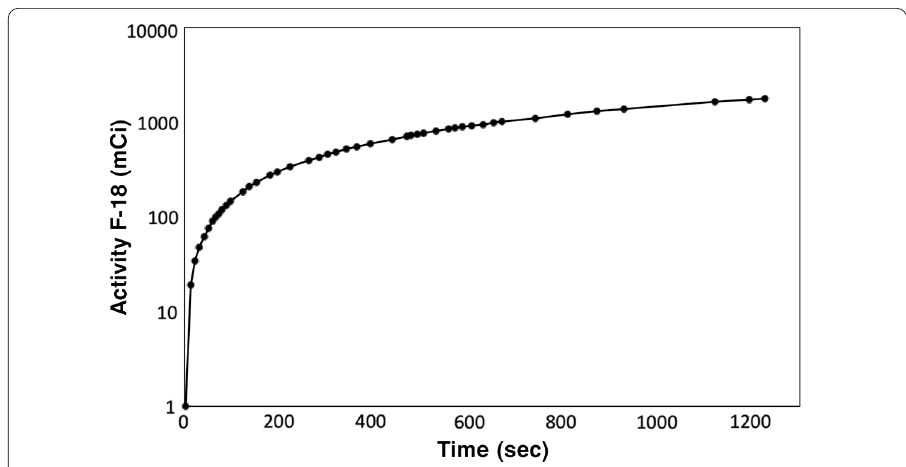
Figure 3 Activity (mCi) of 18 F generated as a function of time (s) in an enriched 18 O target using